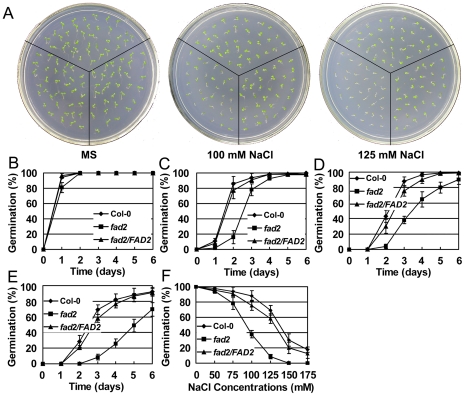
Germination of Col-0, fad2 and fad2/FAD2 under salt treatments.(A) Seeds were sowed on MS medium supplemented with 0 (left), 100 (middle) or 125 mM NaCl (right). Photos were taken seven days after stratification. (B)–(E) Percentage of germinating seeds grown on MS medium supplemented with 0 (B), 75 (C), 100 (D) or 125 (E) mM NaCl. F, Percentages of germinating seeds grown on MS medium supplemented with different concentrations of NaCl three days after stratification. Results are presented as means and standard errors from three independent experiments (≥100 seeds of each line were sown for each experiment).